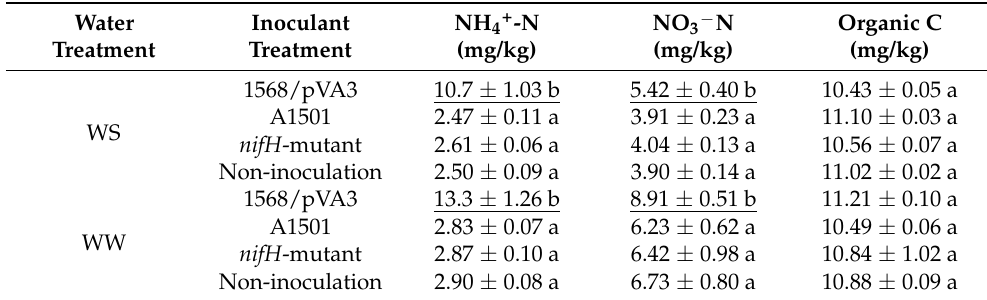
Table 4. Contents of soil ammonium, nitrate and organic C in the rhizospheric soil at day 50 of the maize growing season. The values are mean ± standard deviations (n = 16). Different letters (a–b) indicate a significant difference ( p < 0.05) according to ANOVA analysis. WS—water stress condition; WW—well-watered condition.